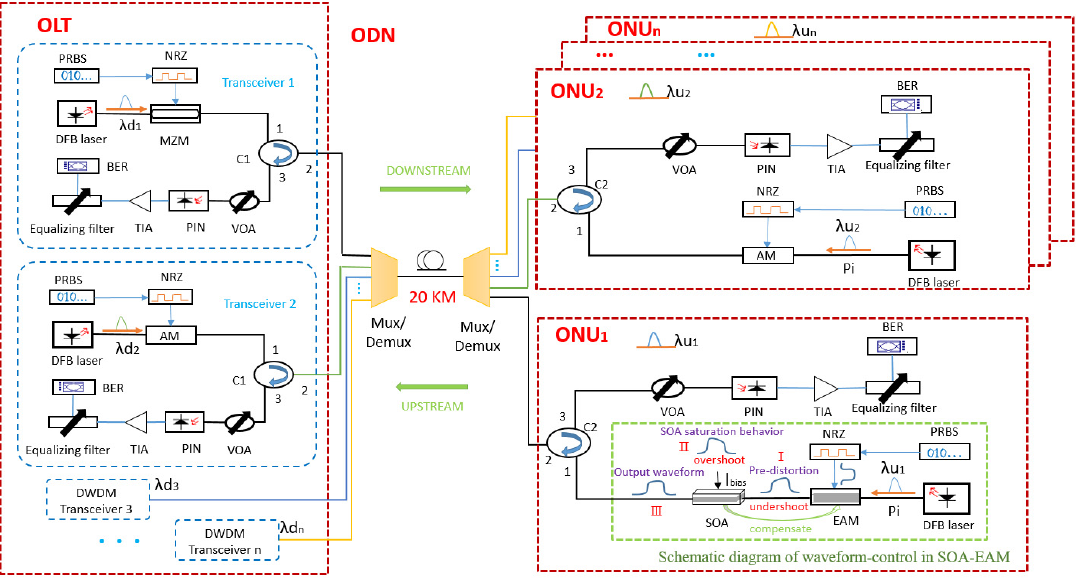
Figure 2. The semiconductor optical amplifier electro − absorption modulator (SOA − EAM)—based optical network unit (ONU) for 10 Gb / s bidirectional transmission (ODN: optical distribution network; C1, C2: circulator; Mux / Demux: multiplexer / demultiplexer; VOA: variable optical attenuator; PIN: PIN − diode; TIA: trans − impedance amplifier).